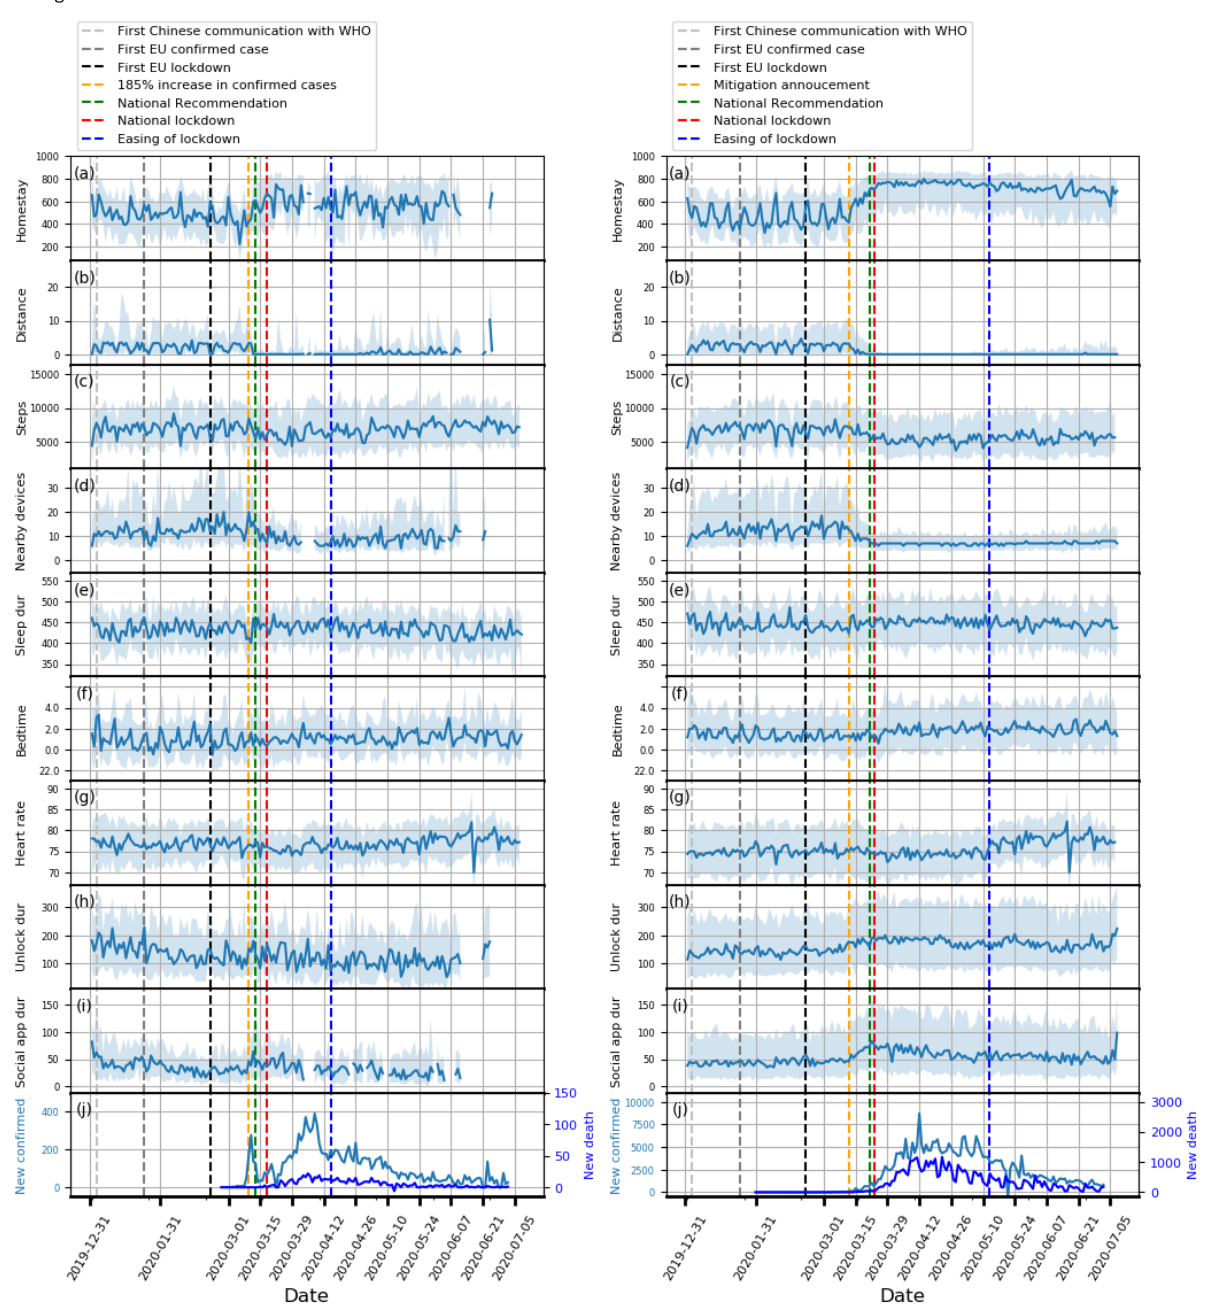
Figure 7. Zoomed in time series plots for Copenhagen, Denmark (left) and the United Kingdom (right). (a) homestay duration, (b) maximum distance from home, (c) Fitbit step count, (d) maximum number of nearby devices, (e) total sleep duration, (f) bedtime, (g) heart rate, (h) unlock duration, (i) social app duration, (j) COVID-19 confirmed and death cases. Solid line: median; shade: 25th percentile to 75th percentile. dur: duration; WHO: World Health